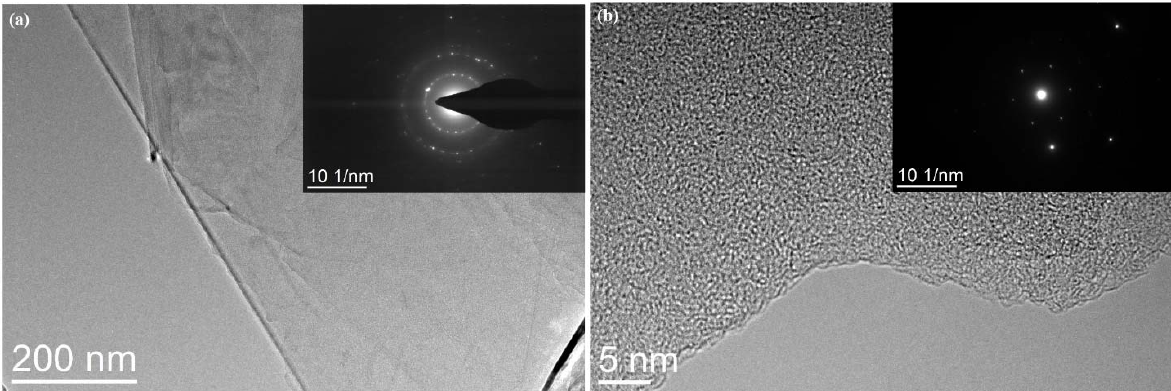
Figure 5. TEM images of GNPs after dispersion.